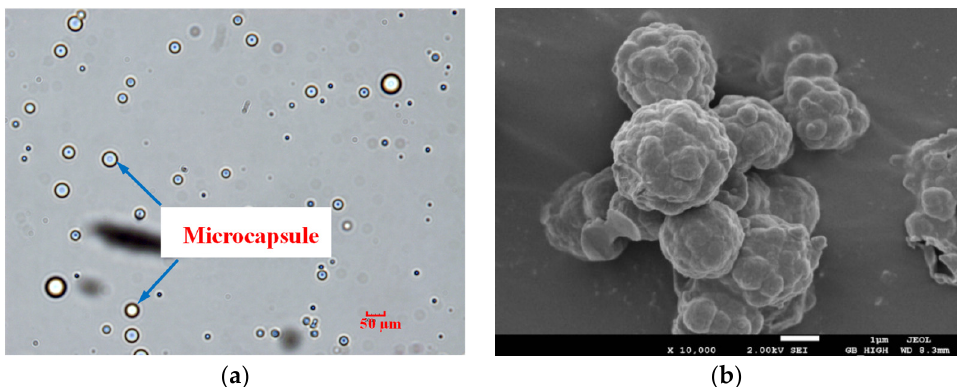
Figure 2. Images of microcapsule: ( a ) optical microscope image; ( b ) SEM image.